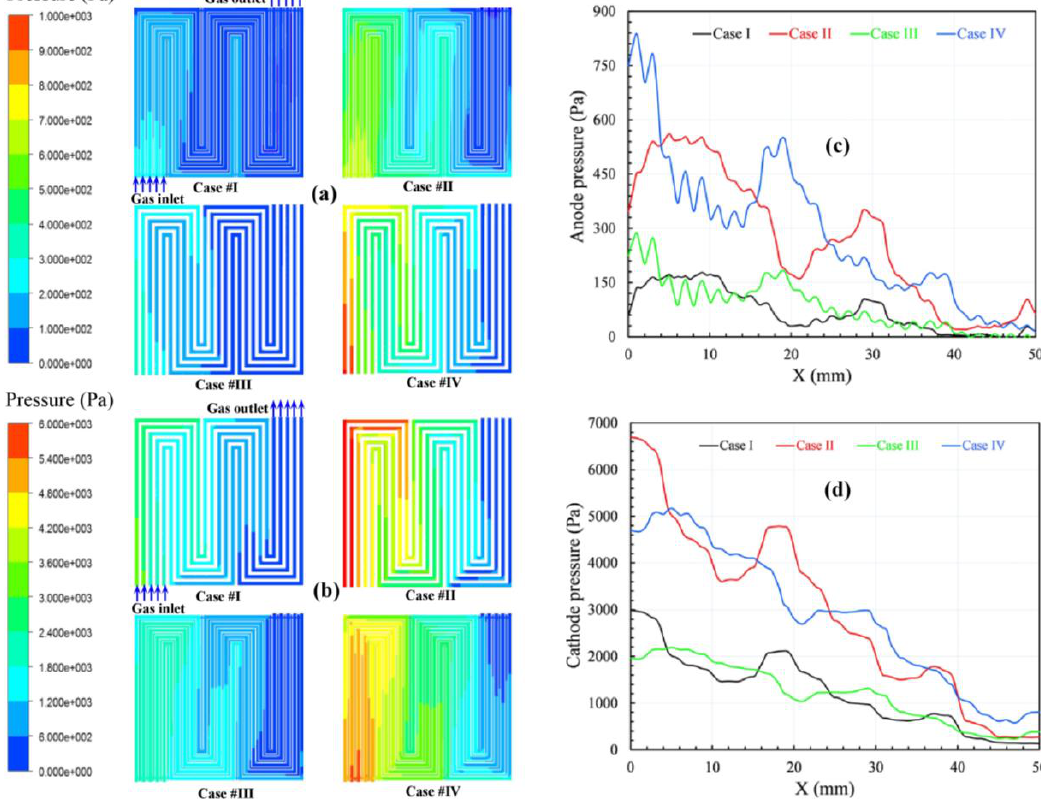
Figure 4. Comparisons of the pressures in four simulation cases at an average current density of 1.2 A/cm 2 : ( a ) total pressure distributions at the anode channel; ( b ) total pressure distributions at the cathode channel; ( c ) total pressures along a reference location of the anode channel; and ( d ) total pressures along a reference location of the cathode channel.